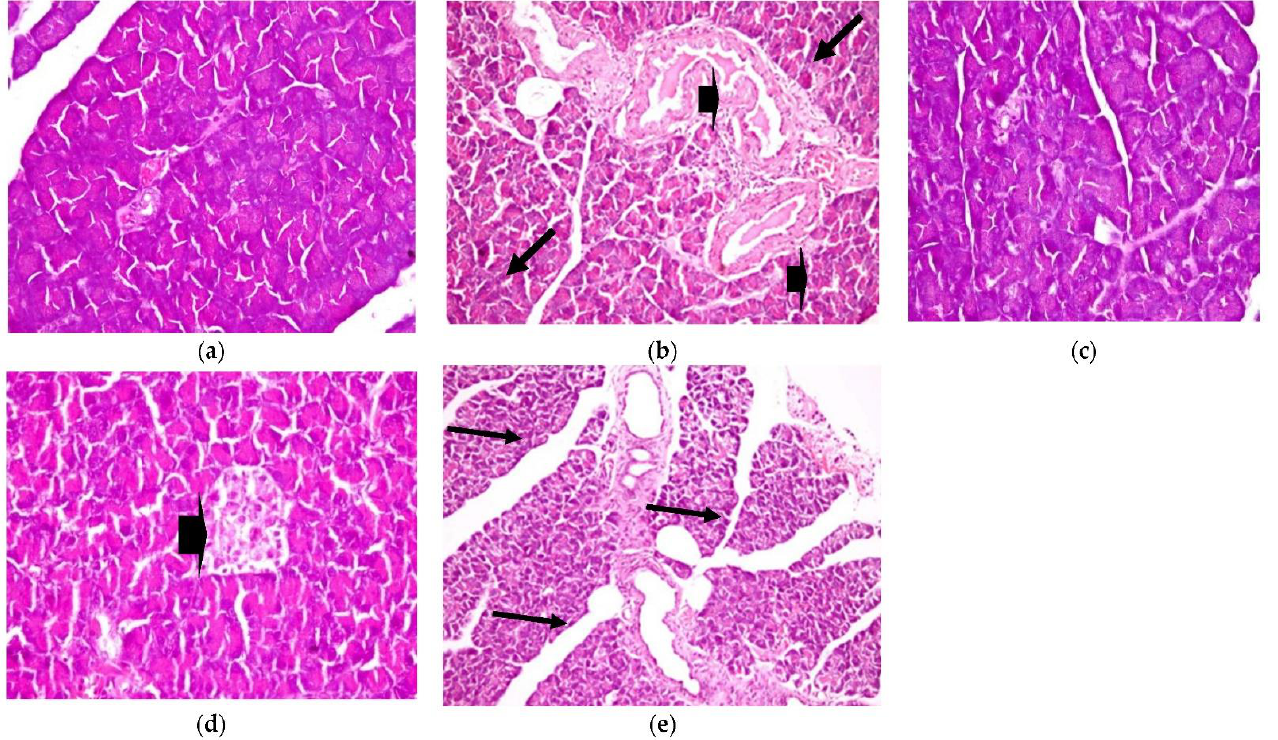
Figure 6. Histopathological examination for (2) pancreas. ( a ) Pancreas from the standard group (Lesion Score: 0), ( b ) pancreas from the positive diabetic group (Lesion Score: ++++), ( c ) pancreas from the group treated with CRB (Lesion Score: 0), ( d ) pancreas from the group treated with CRB (Lesion Score: +) and ( e ) pancreas from the group treated with standard drug (Lesion Score: ++). 3.